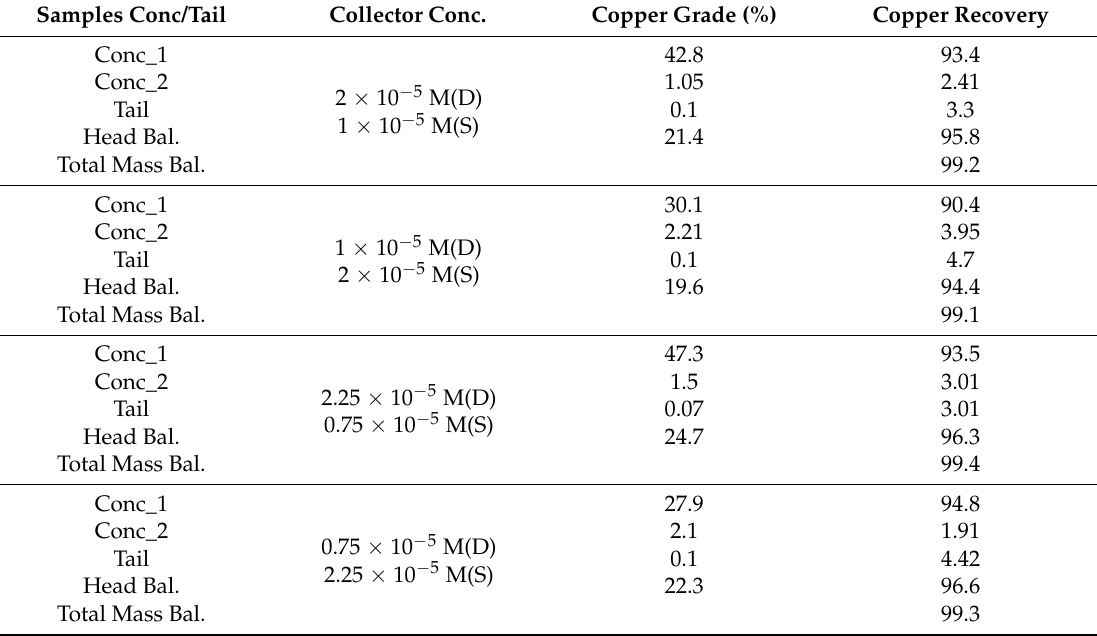
Table 3. The grade and Recovery results with respect to varying collector concentration. Feed grades